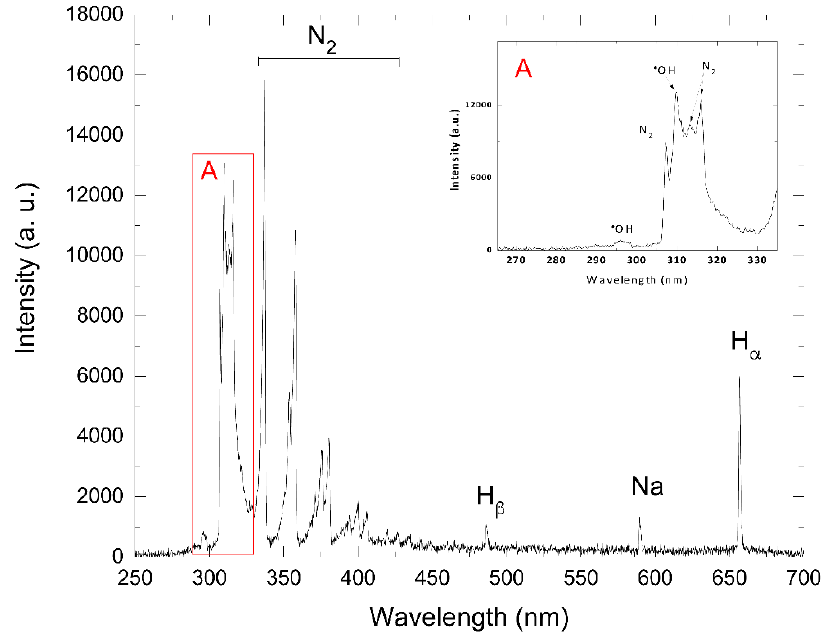
Figure 8. Optical spectrum of plasma emission in the air–liquid interface during the EO–PAP sequenced treatment for azo dye Carmoisine (5 ppm). The pH of the sample was adjusted to 5.2. The treated volume was 1.0 L. The insert shows the absorption spectra of the detection of • OH radicals. Table 1. Electronic transitions species oxidative generates during the PAP